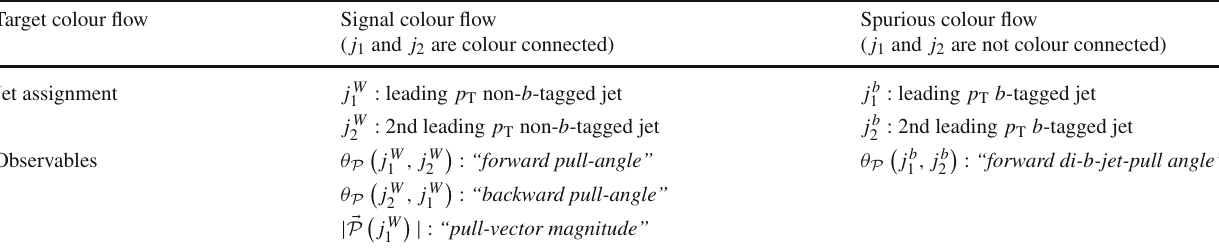
Table 3 Summary of the observables’ definitions Target colour flow Signal colour